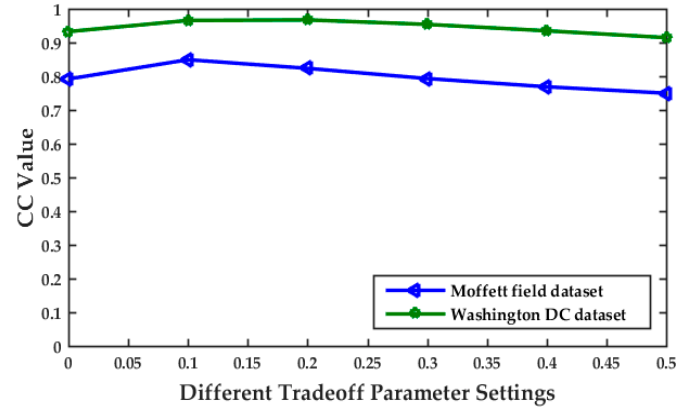
Figure 4. CC values with different tradeoff parameter settings.